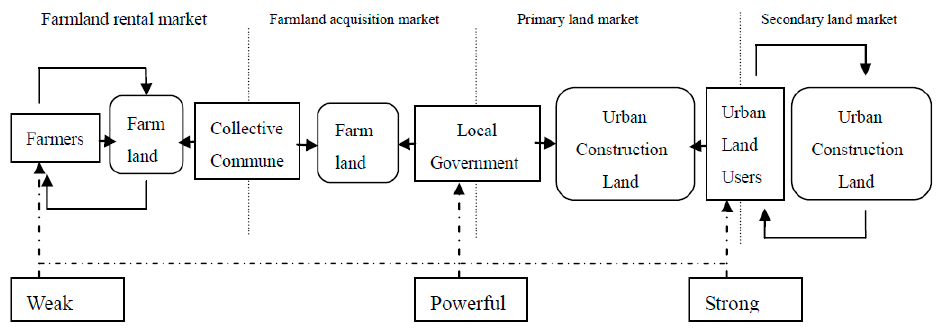
Figure 2. Land market structure in China. Sources based on: [72].